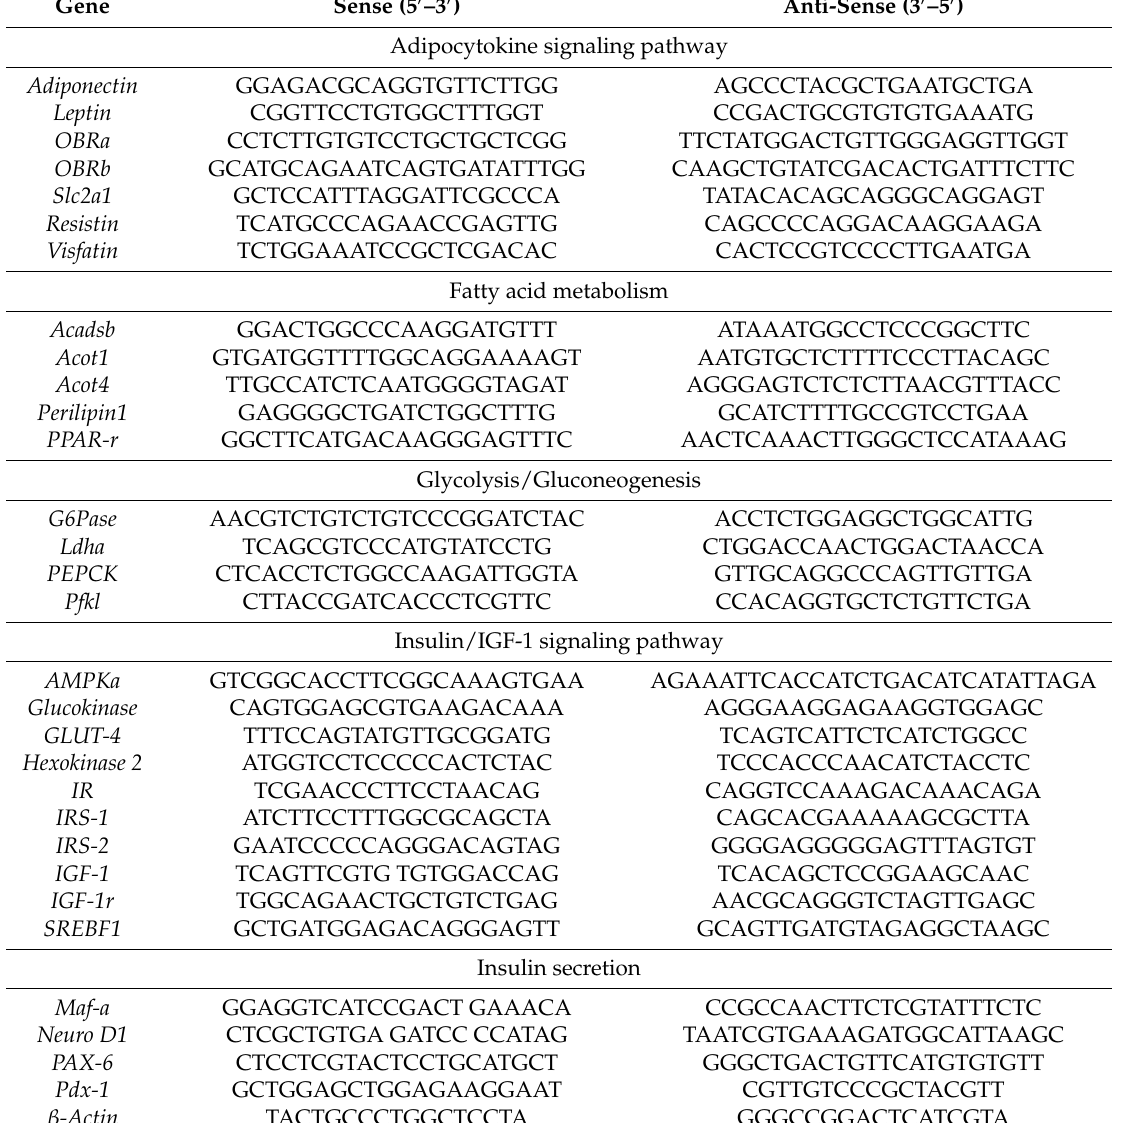
Table 1. Primers used in real-time polymerase chain